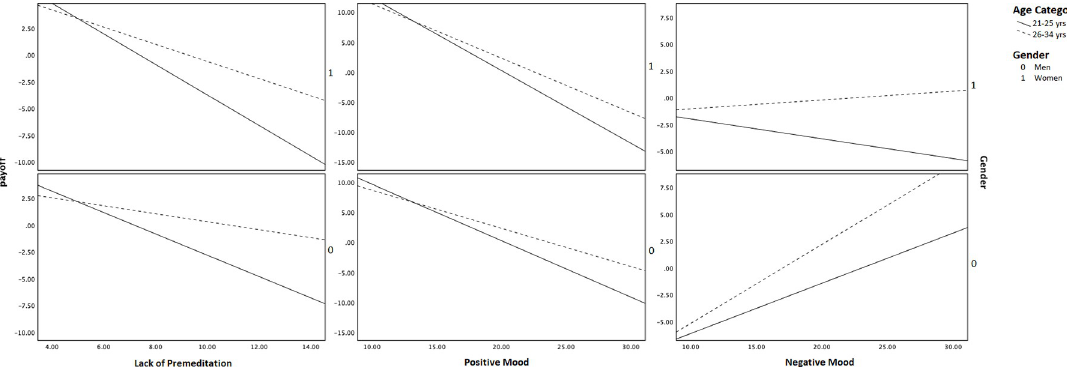
Fig 4. Conditional relationship in mediation-moderation model